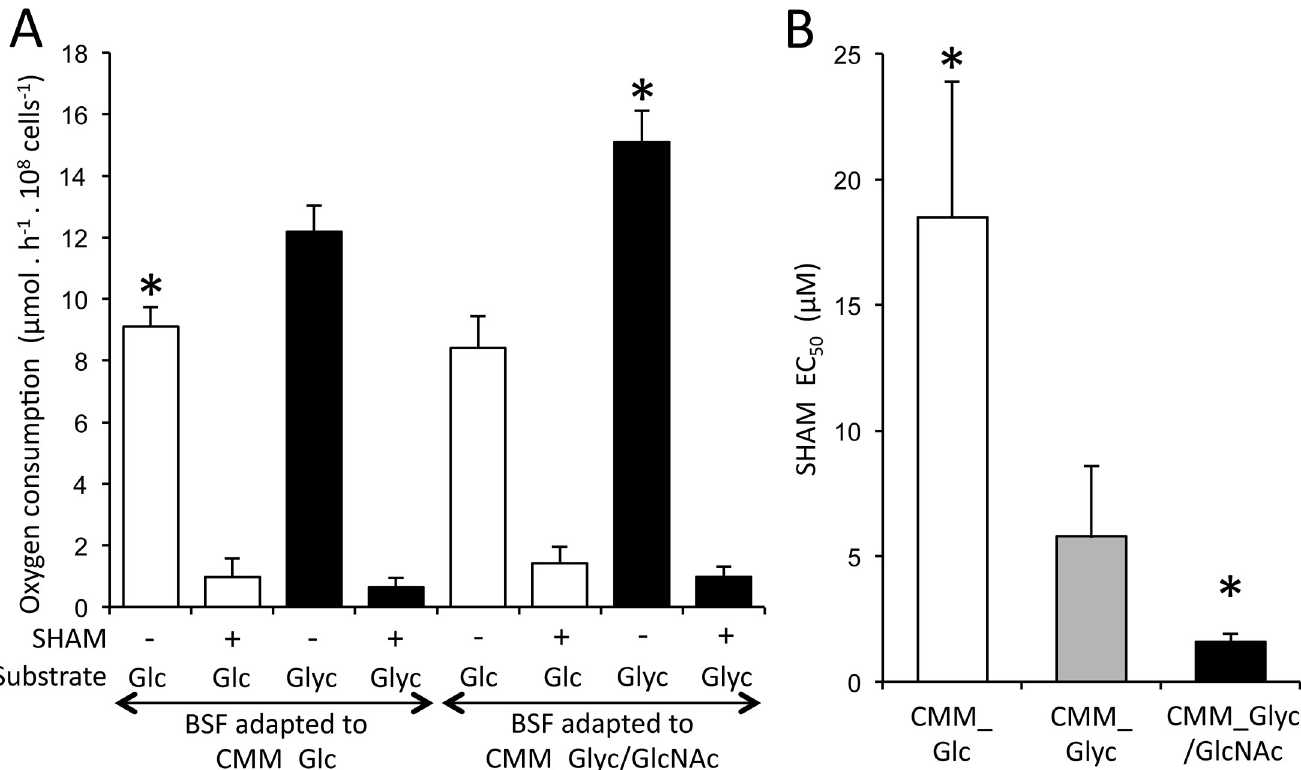
Fig 4. Comparison of oxygen consumption and sensitivity to metabolic inhibitors. Panel A shows oxygen consumption of parental BSF adapted to CMM_Glc or CMM_Glyc/GlcNAc growth conditions and resuspended in fresh CMM containing glucose (Glc, white) or glycerol/GlcNAc (Glyc, black) in the presence (+) or not (-) of 4 mM SHAM (error bars indicate means ± SD of 9 experiments, including 3 biological replicates). The SHAM EC 50 values ( μ M) in BSF adapted to CMM_Glc (white), CMM_Glyc (grey) or CMM_Glyc/GlcNAc (black) are shown in panel B. Error bars indicate means ± SD of 3 biological replicates. The asterisks indicate data relevant for BSF adapted to CMM_Glc (white) and CMM_Glyc/GlcNAc (Black).